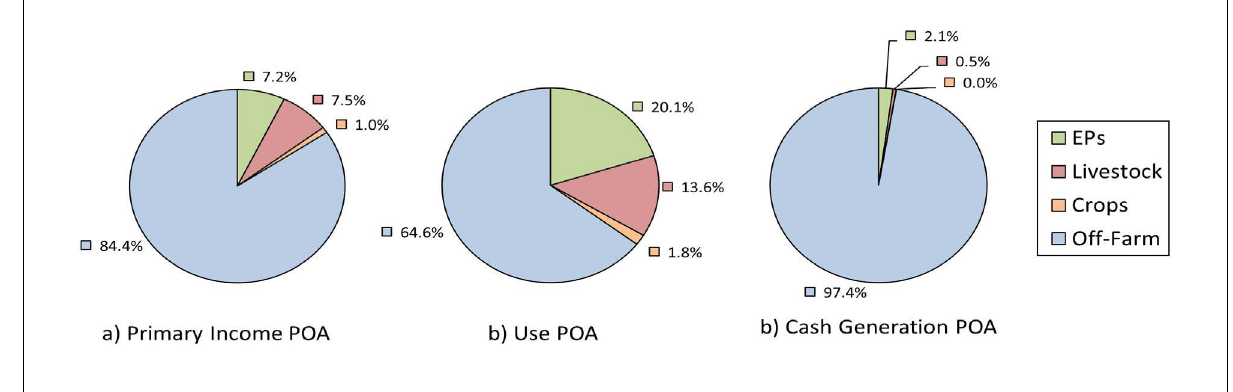
Figure 6: The relative value that each income stream contributes to the mean income portfolio of the study population at the three points of analysis